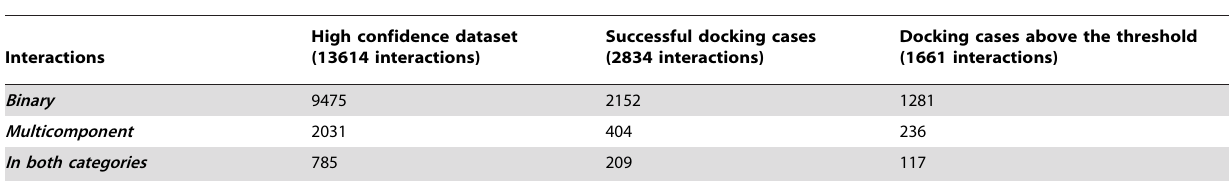
Table 3. Type of the docked